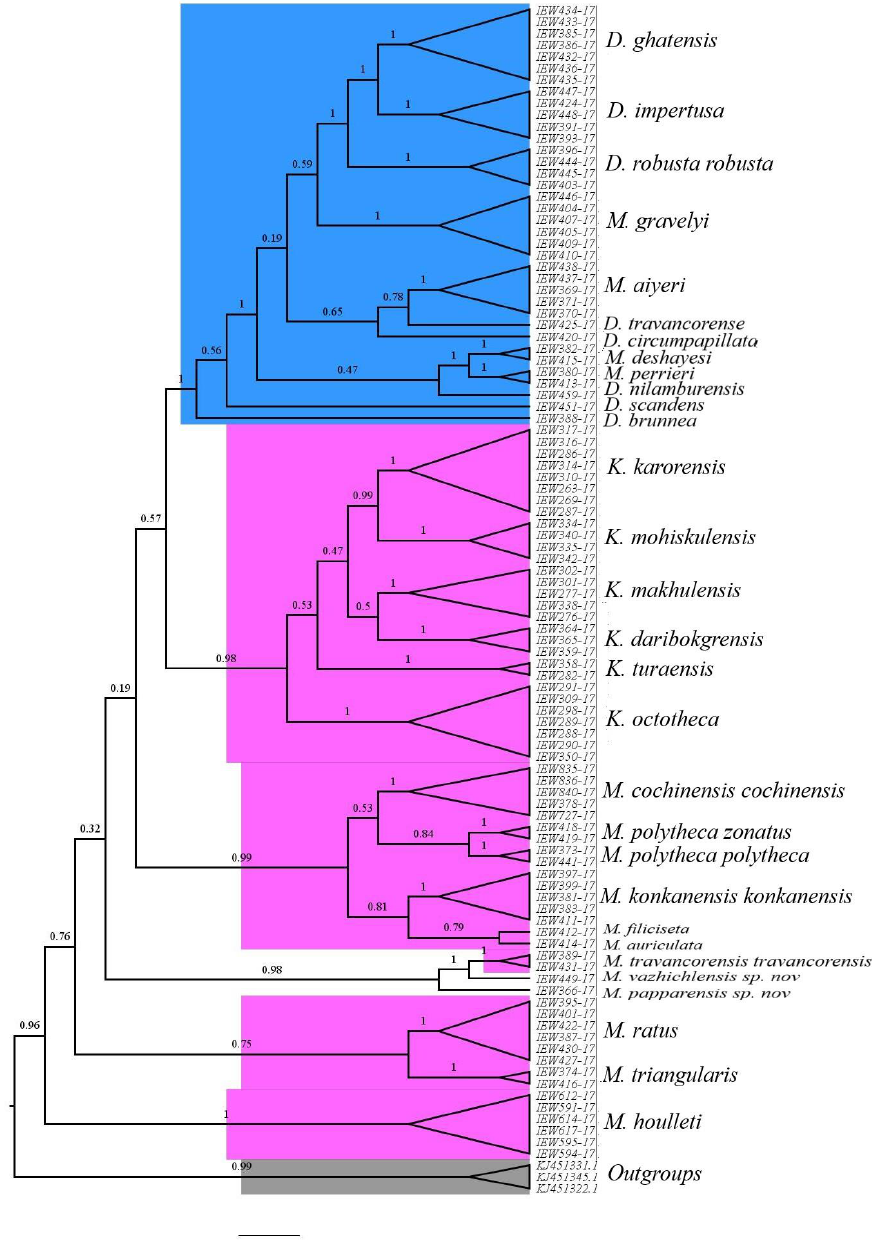
Figure 14. BI phylogenetic tree, depicting paraphyletic clades of Megascolex species with posterior probabilities node values at each node. The families Moniligastridae and Megascolecidae are represented in blue and pink colours; grey colour shows outgroups.